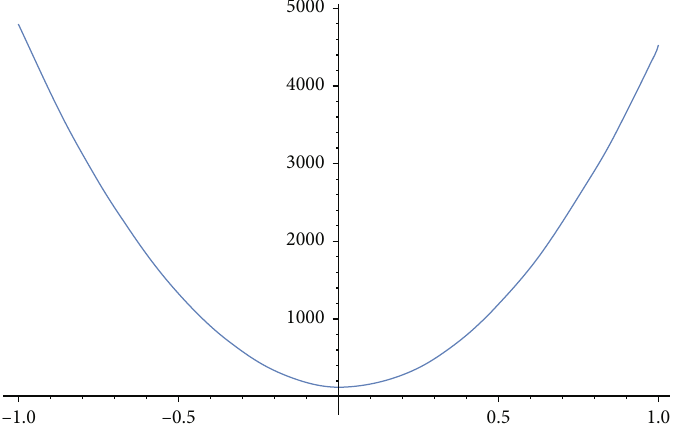
= 0 : 0149 of the variational parameter t of the polynomial function Q ð t Þ = 4526 : 3 t 2 − 134 : 663 t + 121 : 77 Figure 6: The minimum value t min 2 (equation (11)) for the second-order variation in hump-like